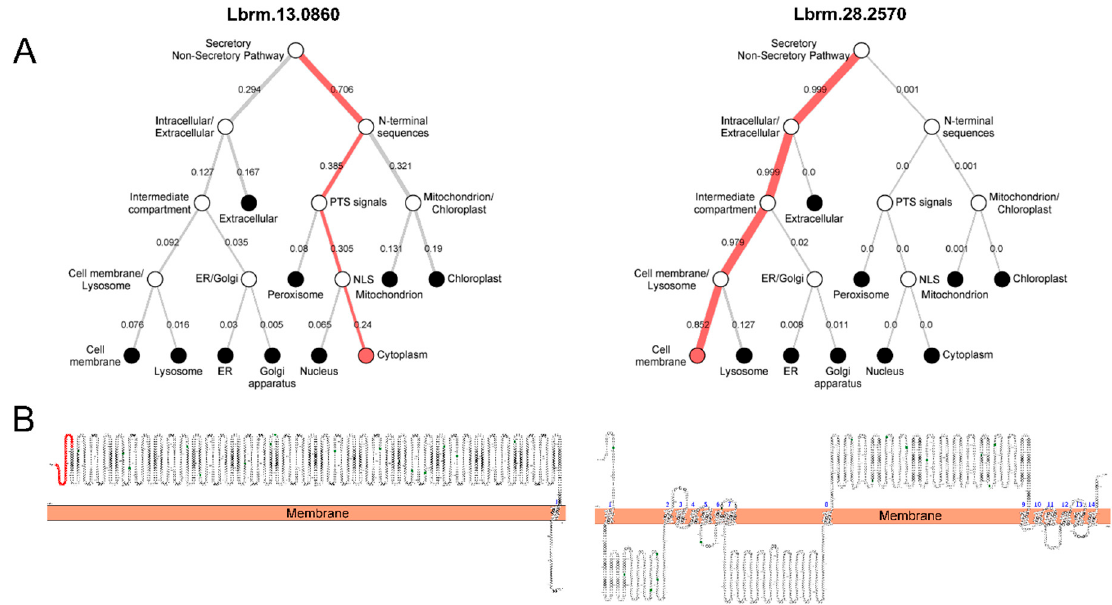
Figure 4. Prediction of the subcellular location of Leishmania (V.) braziliensis subtilisins. LbrM.13.0860 and LbrM.28.2570 were predicted to be located in the cytosol and cellular membrane, respectively, by analysis with the DeepLoc-1 ( A ) and Protter ( B ) servers. In ( A ): hierarchical tree of the prediction of proteins located in cellular compartments. The red lines show the most likely paths of the proteins in the cell calculated by the program. In ( B ): the predicted topological structure of both subtilisins showing proteoforms such as N-glycosytation (green) and the presence of a signal peptide (red). Finger-like projections are loops joining N- and C-terminal groups of transmembrane segments. Blue numbers show the amino acid residues inserted into the cell membrane.